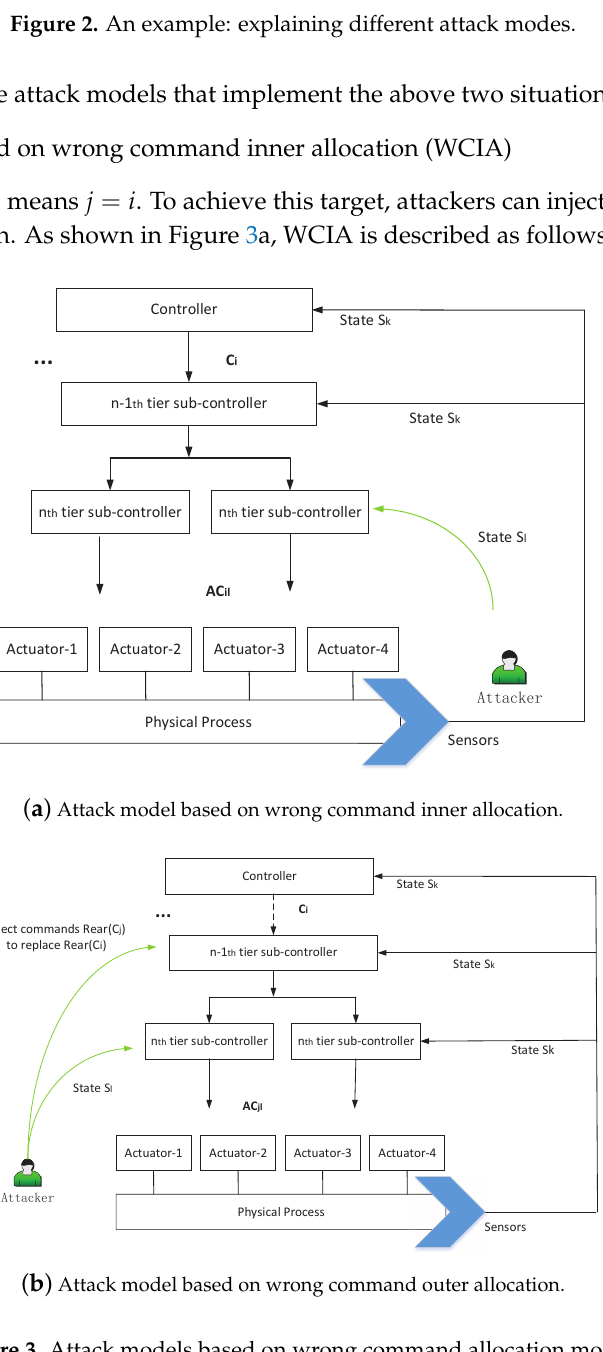
Figure 3. Attack models based on wrong command allocation